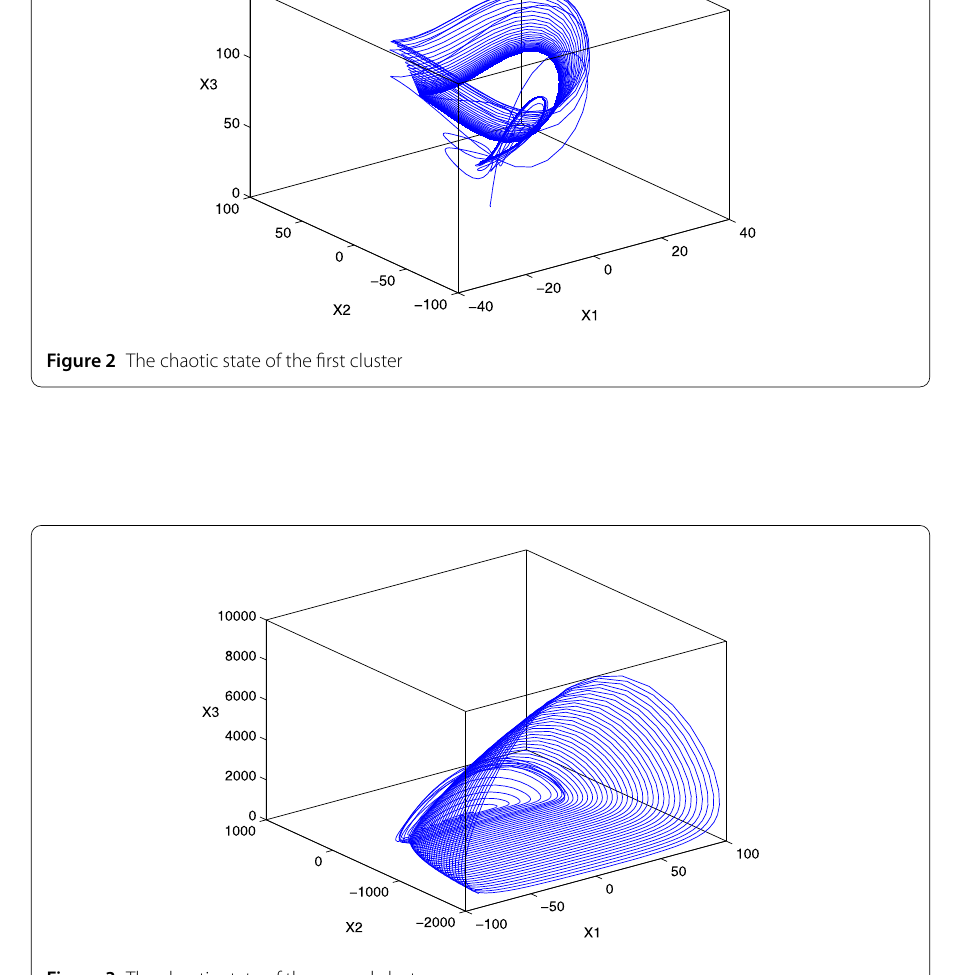
Figure 3 The chaotic state of the second